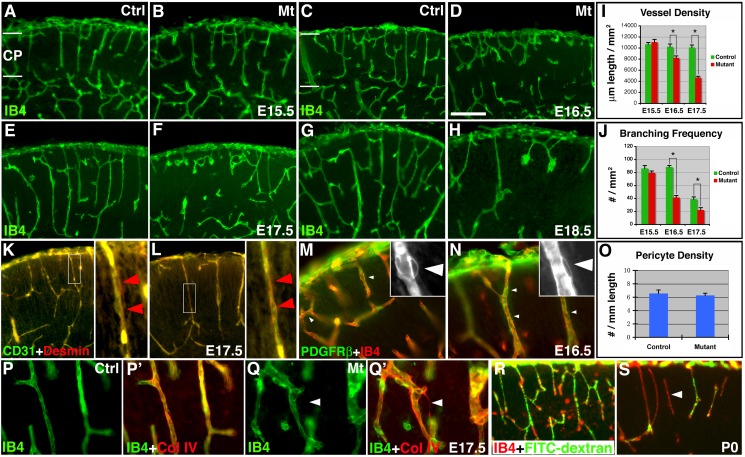
Ablation of neural progenitors results in cortical vessel regression independent of defects in pericyte recruitment.(A–H) Vessel morphology from E15.5 to E18.5. IB4 staining (in green) revealed no obvious defects at E15.5 (A and B) but significant defects at E16.5 (C and D), E17.5 (E and F), and E18.5 (G and H). (I–J) Quantification of vessel density and branching frequency from E15.5–17.5. Significant decreases (*) in both parameters were observed at E16.5 (p = 0.03 and 0.0003, n = 3) and E17.5 (p = 0.7×10−5 and 0.007, n = 5), but not at E15.5 (p = 0.52 and 0.25, n = 4). (K–N) Pericyte investment of vessels. Desmin staining (in red) surrounds CD31+ (in green) vessels similarly in mutants (L), as in controls (K). Boxed areas in (K and L) are shown in two right panels. PDGFRβ+ (in green) cells (some highlighted by arrowheads) were also associated with IB4+ (in red) vessels similarly in mutants (N), as in controls (M). PDGFRβ staining in boxed areas are shown as insets. (O) Quantification of PDGFRβ+ pericyte density. Pericytes along all vessels were quantified. No significant differences were observed (p = 0.62, n = 4). (P–Q′) Collagen IV staining. Collagen IV+ (in red) empty sleeves (arrowheads in Q′) were frequently observed in mutants (Q–Q′), in contrast to controls (P–P′). (R–S) Vessel perfusion. Neonates were perfused trans-cardially using 1% FITC-dextran (in green) followed by IB4 (in red) staining. Many vessels in mutant brains (S) were not well perfused (arrowhead in S), in contrast to those in controls (R). Scale bar (in D): 200 µm for (A–H), (K–N), and (R–S), 80 µm for (P–Q′).